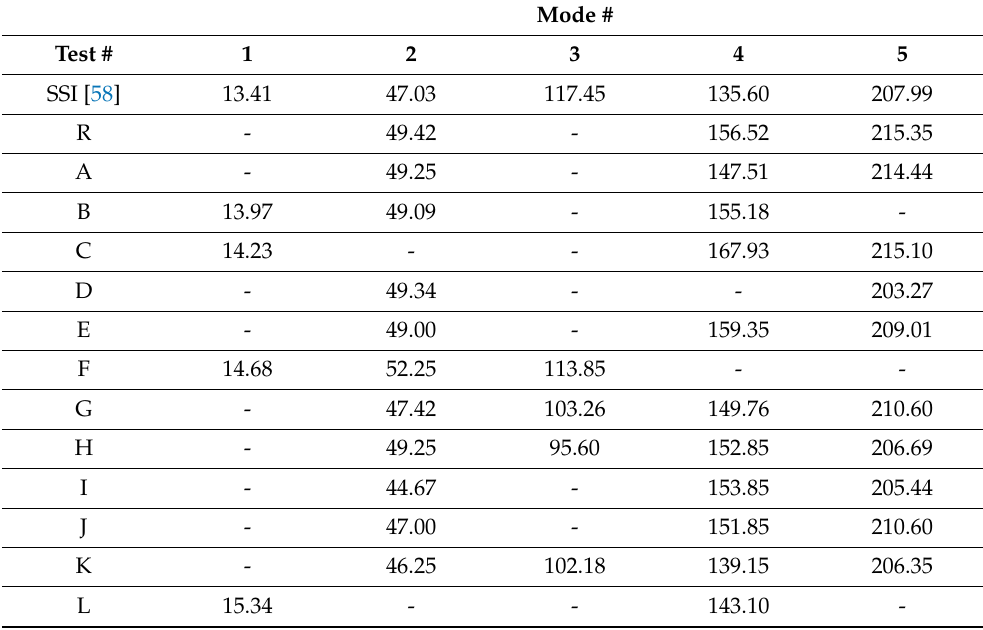
Table 7. Identified modal frequencies (Hz) of the wind turbine blade at +25 ◦ C using TVF-EMD by considering a 4 .